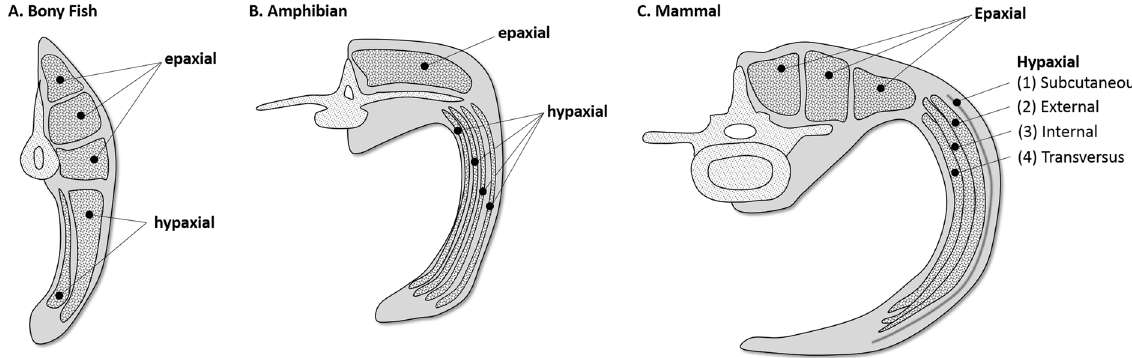
Figure 2. Muscles of the ventrolateral body wall in the vertebrate abdomen derived from the embryonic hypaxial and epaxial masses. ( A ) In fishes, such as teleosts, hypaxial muscles of the ventrolateral wall are organized into two layers ( M. obliquus superioris and M. obliquus inferioris ). ( B ) Amphibians, such as salamanders, have two to four layers ( M. obliquus externus , in some species divided into superficialis and profundus portions, M. obliquus internus , and M. transversus abdominis , with scattered subcutaneous skeletal muscle fibers). ( C ) Mammals, like dogs, consistently have four layers ( M. cutaneous trunci , a well-developed subcutaneous muscle layer, M. obliquus externus abdominis , M. obliquus internus abdominis and M. transversus abdominis ). Development of the ventral musculature, such as M. rectus abdominis , is regulated by different molecular signals and therefore follows a different organizational pattern and may not differentiate into multiple layers 12 .